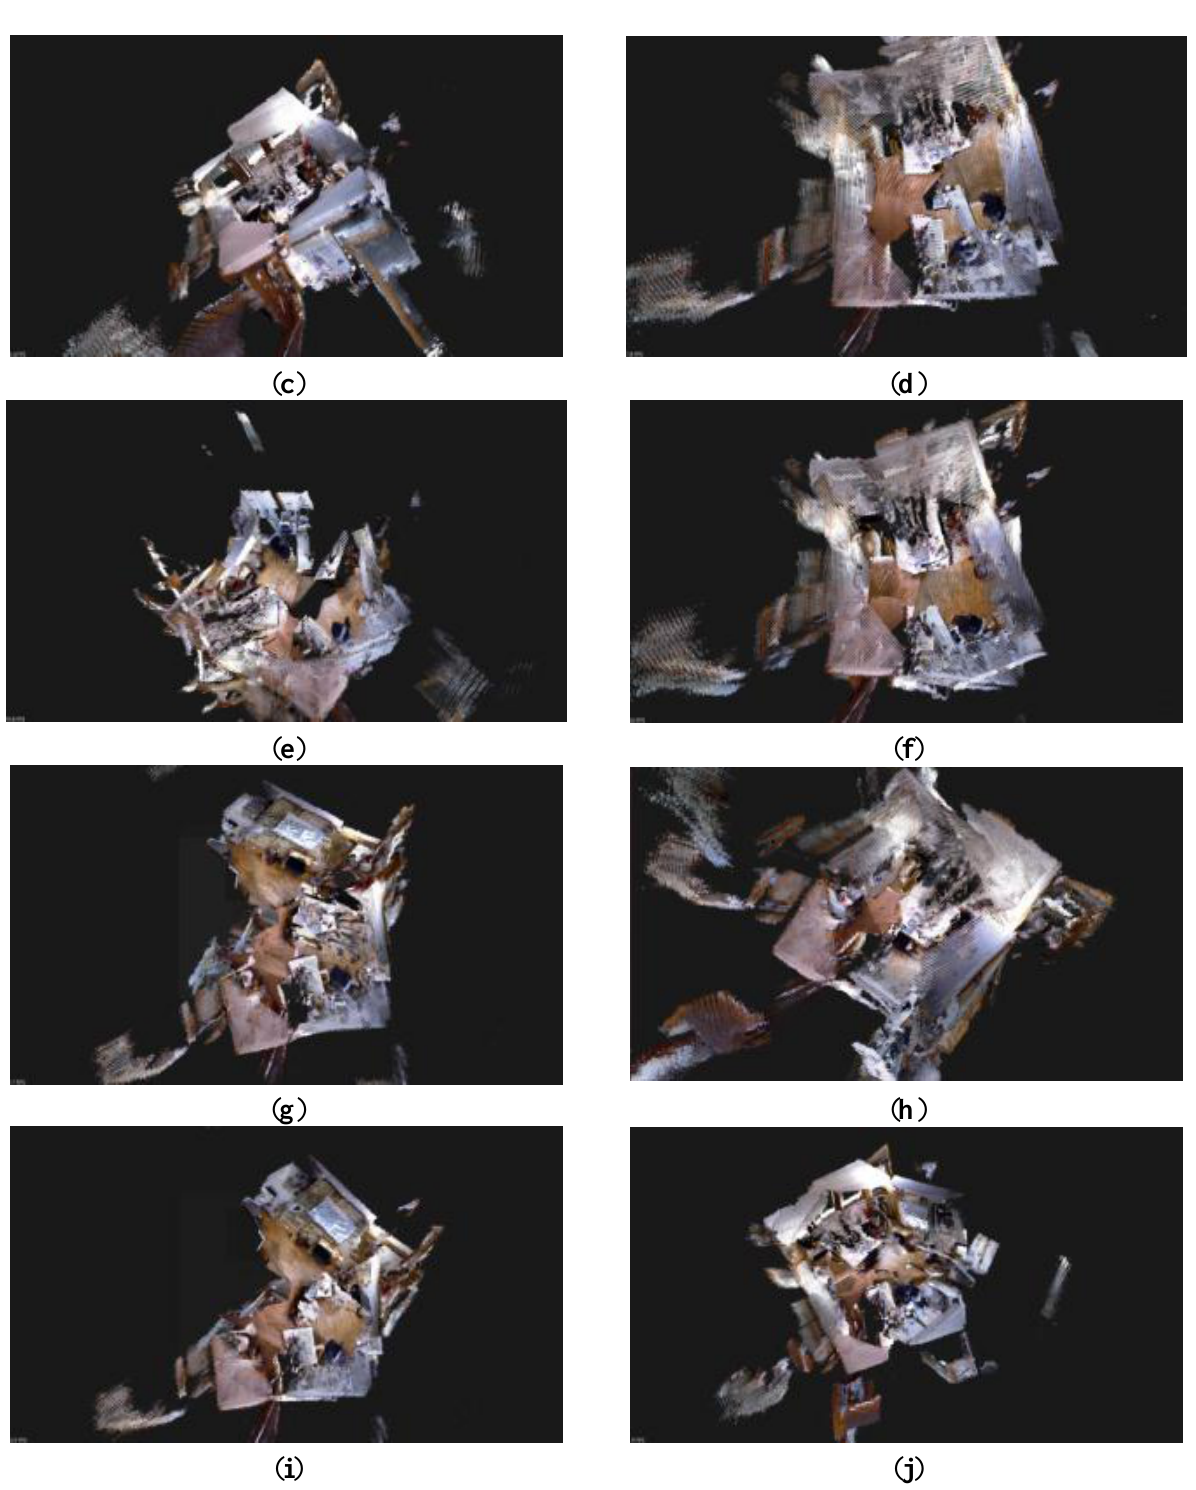
Figure 12. The results for stitching on the original and the improved front-end